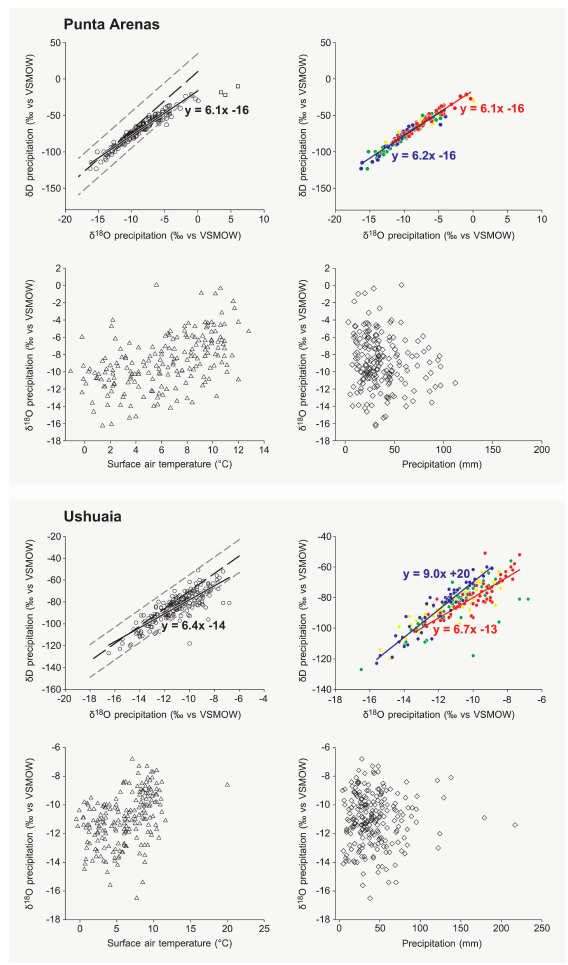
of Isotopes in Precipitation (GNIP) (International Atomic Energy Agency–World Meteorological Organization (IAEA/WMO), 2004) stations at Punta Arenas, Chile, and Ushuaia, Argentina. For each site: Upper left graph= δ D and δ 18 O-values in meteoric waters for 1990–2008 (Punta Arenas) and 1982–2002 (Ushuaia). Lo- cal meteoric water lines (MWL) are indicated with solid lines: δ D=6.1( δ 18 O) − 16 at Punta Arenas, and δ D=6.4 ( δ 18 O) − 14 at Ushuaia. Global MWL is given as black dashed line (Craig, 1961). Upper (lower) grey dashed lines indicate meteoric waters from drier (more humid) moisture sources. Upper right graph=variation in isotopic composition of meteoric waters by season (blue circles, June–August; green circles, September–November; red circles, December–February; yellow circles, March–May). Sea- sonal MWLs are indicated. For Punta Arenas: June–August, δ D=6.2 ( δ 18 O) − 16; December–February, δ D=6.1 ( δ 18 O) − 16. For Ushuaia: June–August, δ D=9.0 ( δ 18 O)+20; December– February, δ D=6.7 ( δ 18 O) − 13. Lower left graph=monthly air temperature values and oxygen isotopic composition of monthly precipitation (IAEA/WMO, 2004). Lower right graph=monthly to- tal precipitation values and oxygen isotopic composition of monthly precipitation (IAEA/WMO,